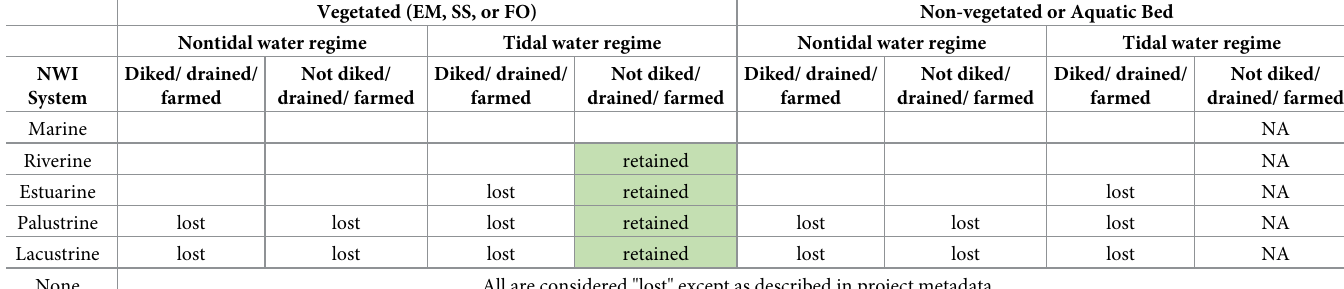
Table 3. Summary of tidal wetland loss classification for National Wetlands Inventory (NWI) wetland types. Blank cells represent attribute combinations not present in the database. "Lost" indicates wetlands that were probably once vegetated tidal wetlands, but are no longer in that category. "Retained" indicates areas that were probably historically vegetated tidal wetlands and still remain in that category. "NA" indicates wetlands omitted from the analysis, because the analysis is limited to emergent (EM), scrub-shrub (SS) and forested (FO) tidal wetland vegetation